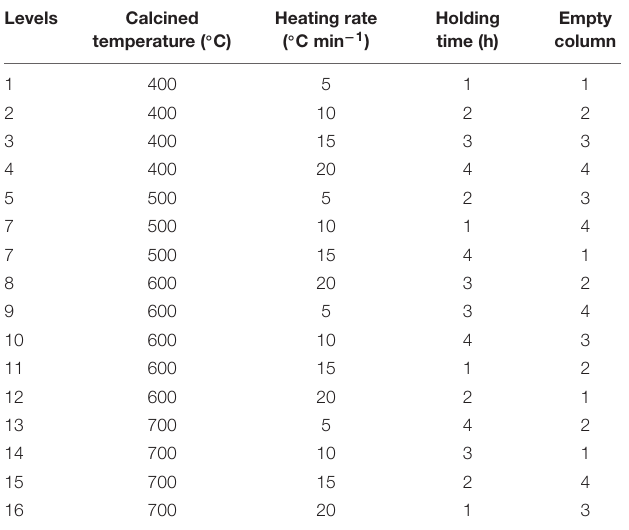
TABLE 1 | Calcined process orthogonal test level of